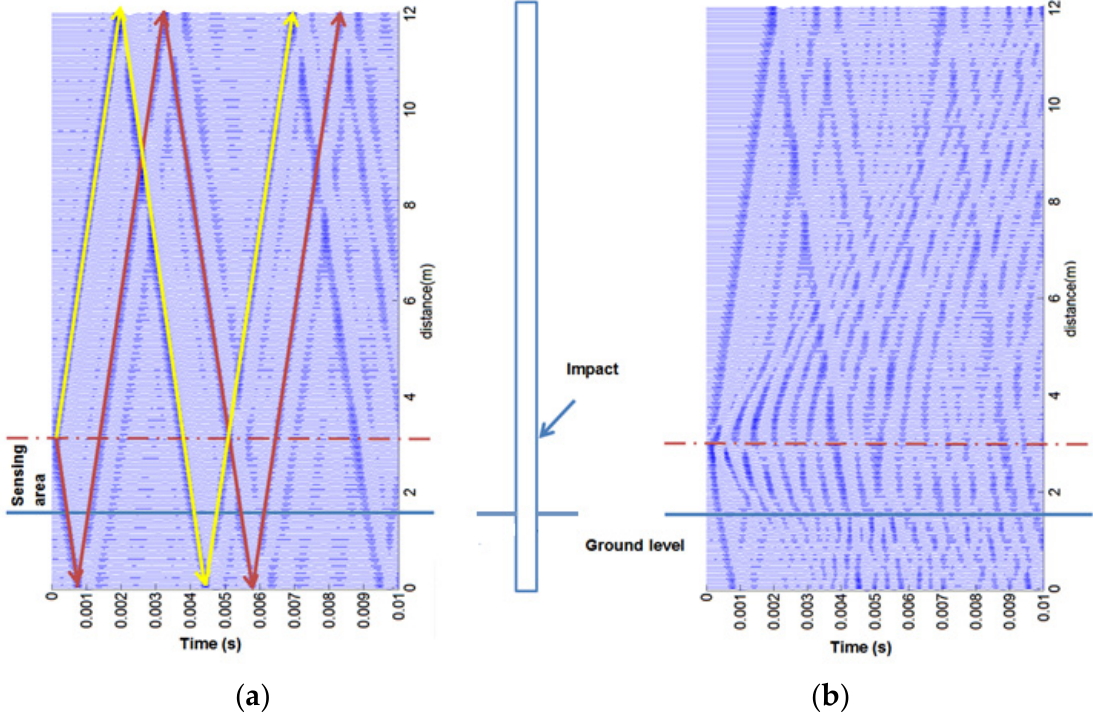
Figure 21. Wave trace of a 12 m pole for side excitation with ( a ) isotropic and ( b ) orthotropic material